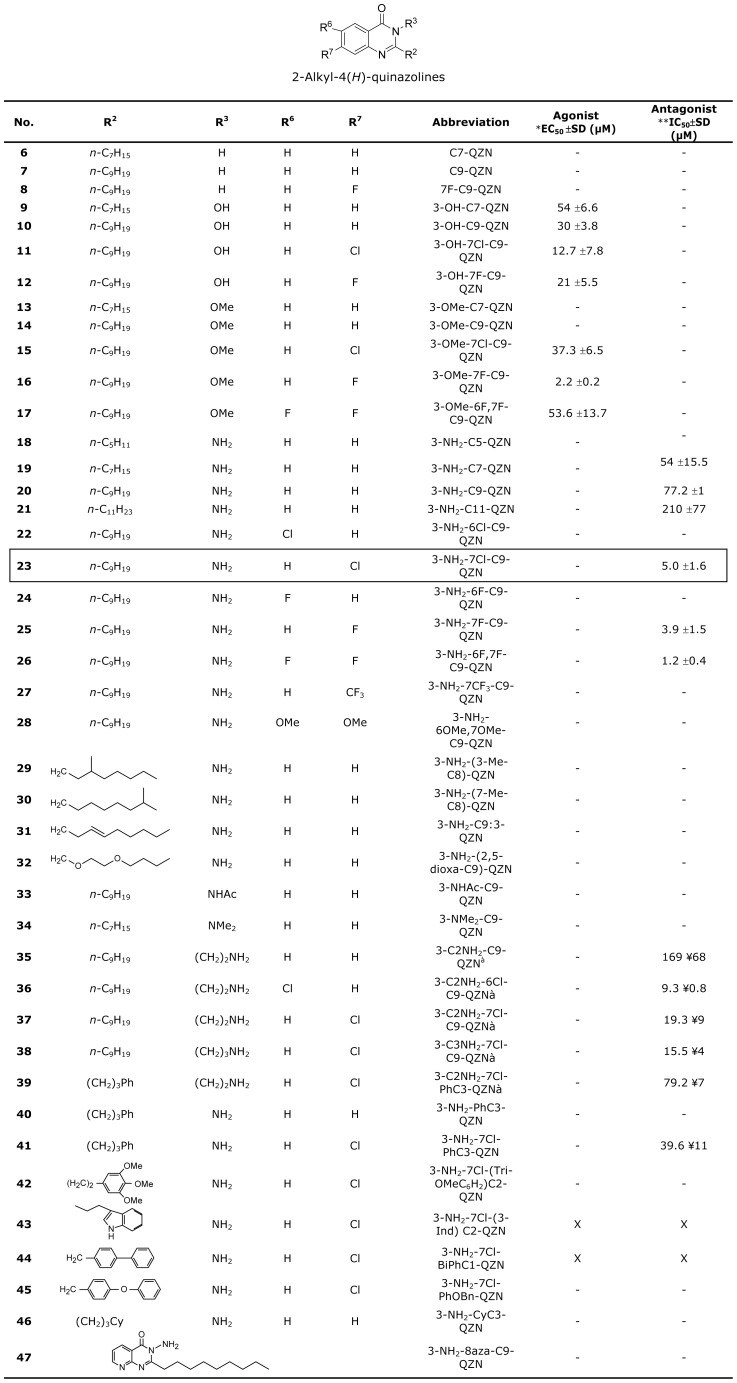
Activation and inhibition of PqsR in P. aeruginosa by the 2-alkyl-4(3H)-quinazolinones.*EC50 determined in a P. aeruginosa ΔpqsA miniCTX::pqsA'-lux strain; **IC50 determined in a P. aeruginosa wild type strain incorporating a miniCTX::pqsA'-lux fusion; – no activity; ‡compounds exhibited growth inhibition; X compounds did not dissolve in MeOH at a workable concentration; 3-NH2-7Cl-PhOBn-QZN (46) is barely soluble.